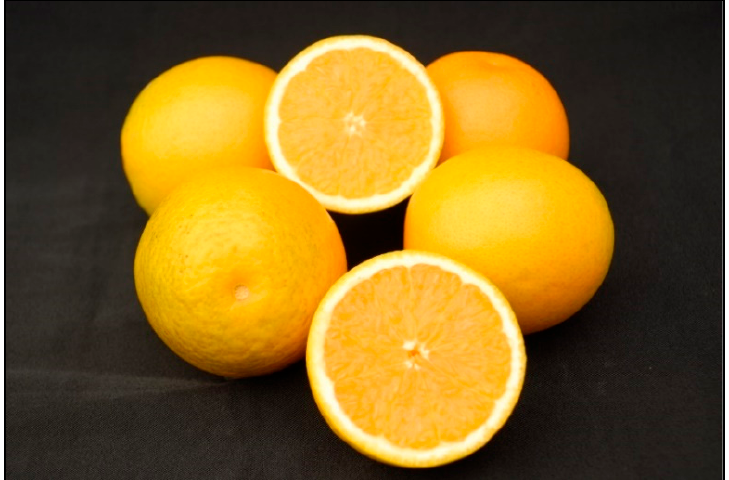
Figure 5. Fruit of ´ Candidatus Liberibacter asiaticus’ non-inoculated ( C Las − ) STX-5 transgenic line of Pera sweet orange ( Citrus × sinensis ) plants, produced under greenhouse conditions.